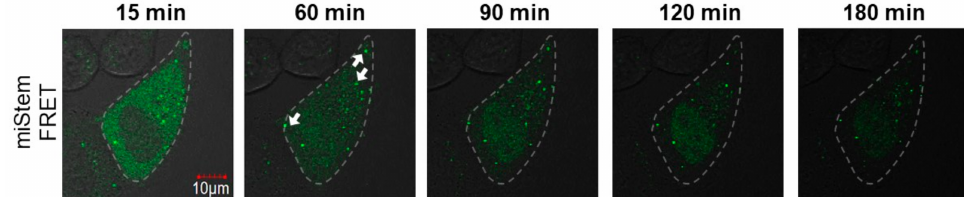
Figure 7. Time course of miStem in a living cell. The FRET signal of miStem transfected by the beads loading method was observed by confocal laser microscopy. The outline of the cell is represented by the dotted line. The white arrows represent the foci generated during the tracking analysis. The FRET signals were recorded as follows: Ex = 458 nm, Em = 555–625